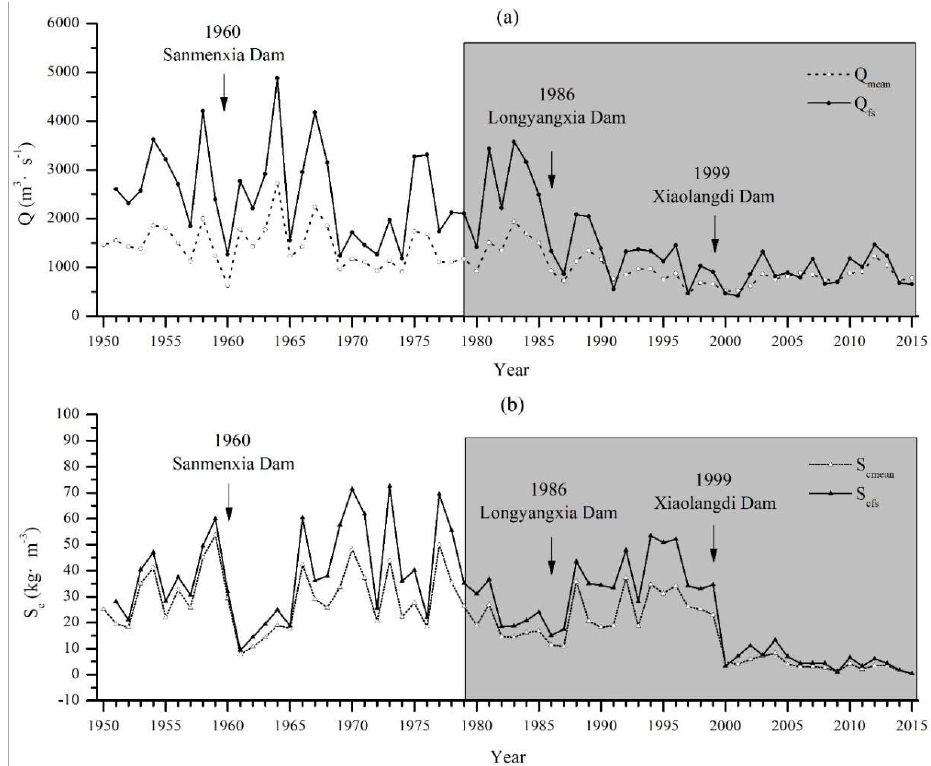
Figure 6. Variations of annual mean flow discharge Q mean and annual flood-season mean flow discharge Q fs : ( a ) and annual average concentration of suspended sediment S c ; and ( b ) recorded at the Huayuankou station from 1950 to 2015.